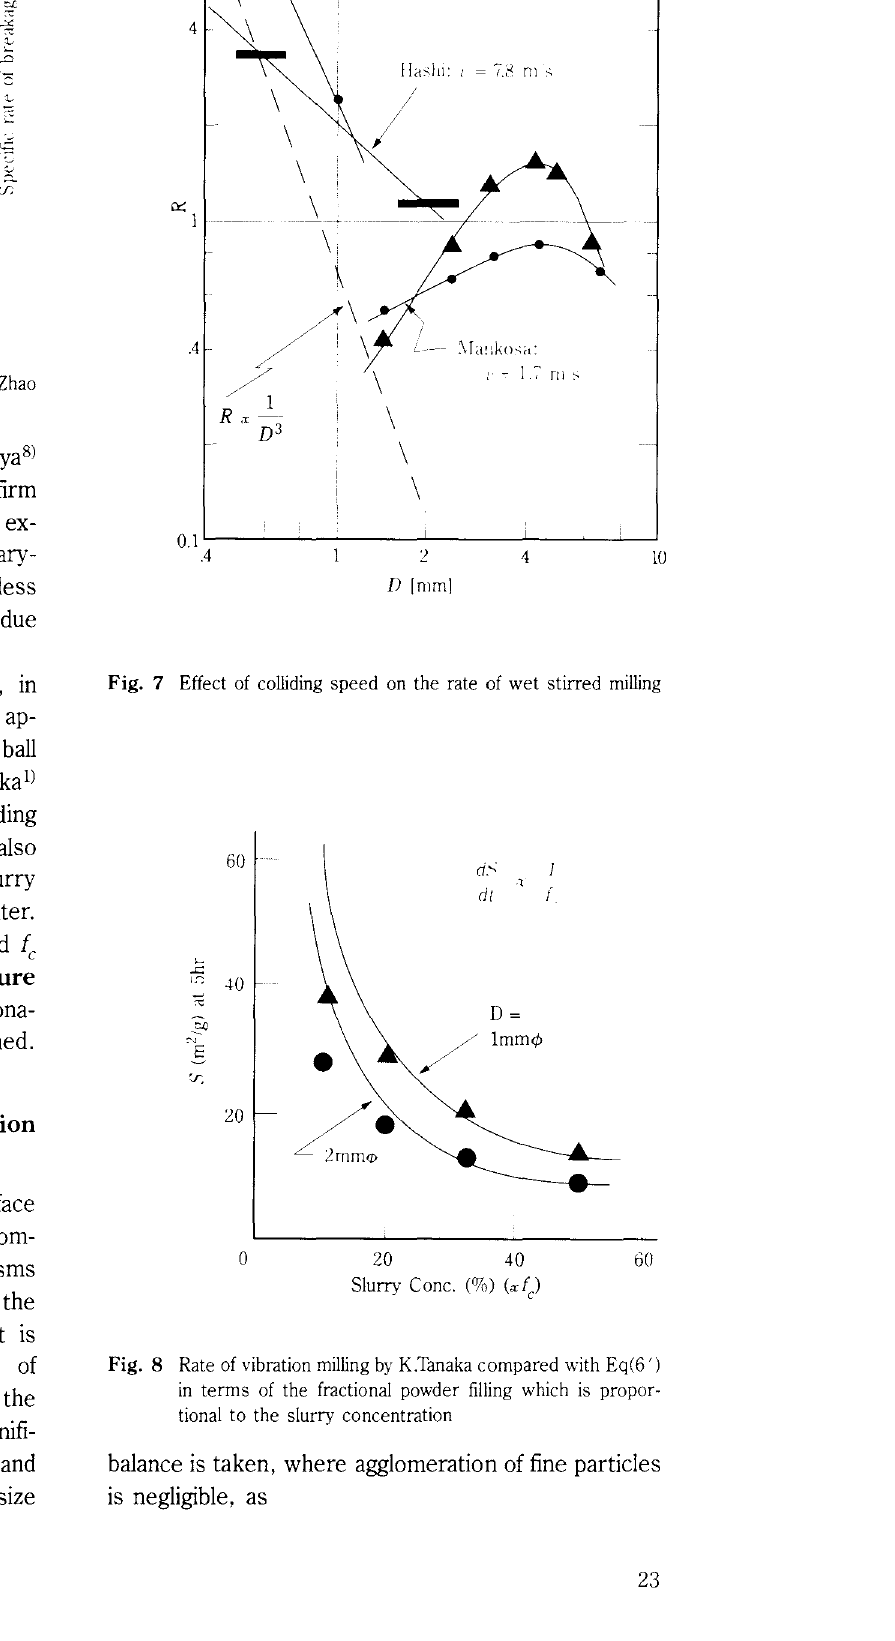
Fig. 6 Comparing the rate of milling by dry planetary mill by Zhao with Eq(6') in terms of particle size crushed.